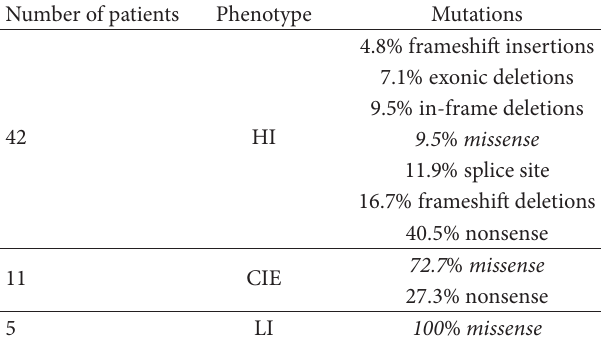
T 2: A summary of the types of mutations identi�ed (from the literature review) for each subtype of ARCI (autosomal recessive congenitalichthyosis)andthecorrespondingeffectsontheABCA12 protein. is table shows that the most deleterious changes oen result in the HI phenotype, while the mutations which have a less severe effect on the protein oen lead to the CIE and LI